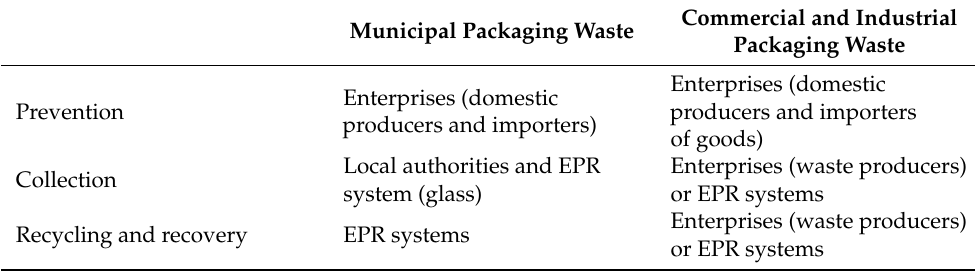
Table 7. Responsibilities for prevention, collection, recycling, and recovery in